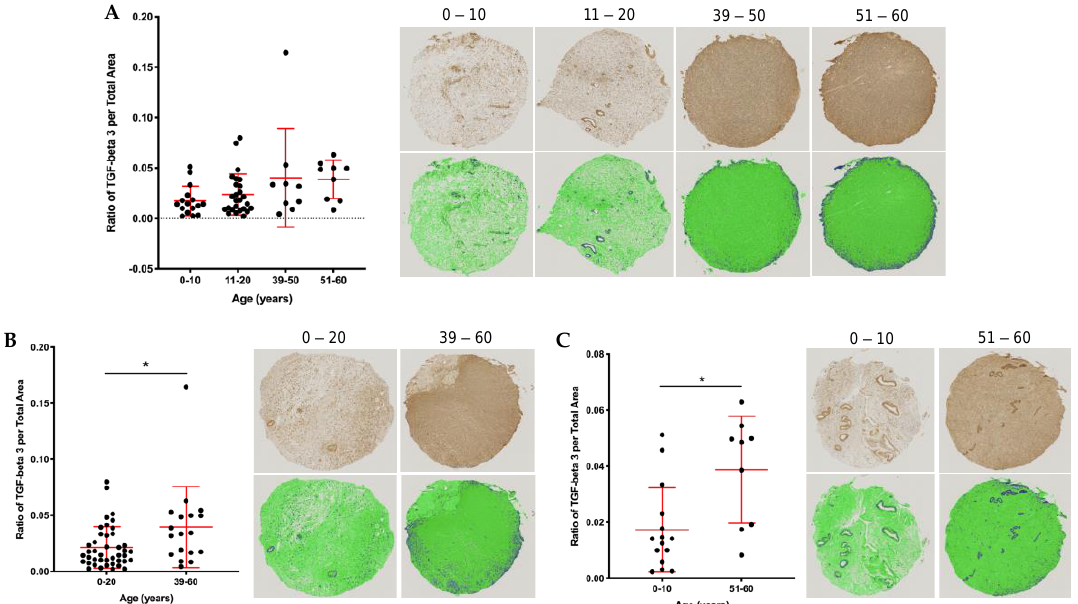
Figure 6. Quantitative analysis of human ovarian tissue microarray (TMA) reveals increased TGF β 3 content with age. ( A ) Average ratio of TGF β 3 expression per total area for core 1 and core 2 (unique cores from the same patient) broken down into four age cohorts: 0–10, 11–20, 39–50, 51–60. Images from cores closest to the average data point in each age cohort are shown with TGF β 3 staining (brown) in the panel above and quantitative data analysis in green and blue below. The dark blue area represents a positive TGF β 3 signal above the threshold, while green is TGF β 3 negative. ( B ) Ratio of TGF β 3 per total area in the 0–20 vs. 39–60 age cohorts. ( C ) Ratio of TGF β 3 per total area in the 0–10 vs. 51–60 age cohorts. Asterisks (*) indicate statistical significance with panel ( B ) p = 0.01 and panel ( C ) p = 0.005.